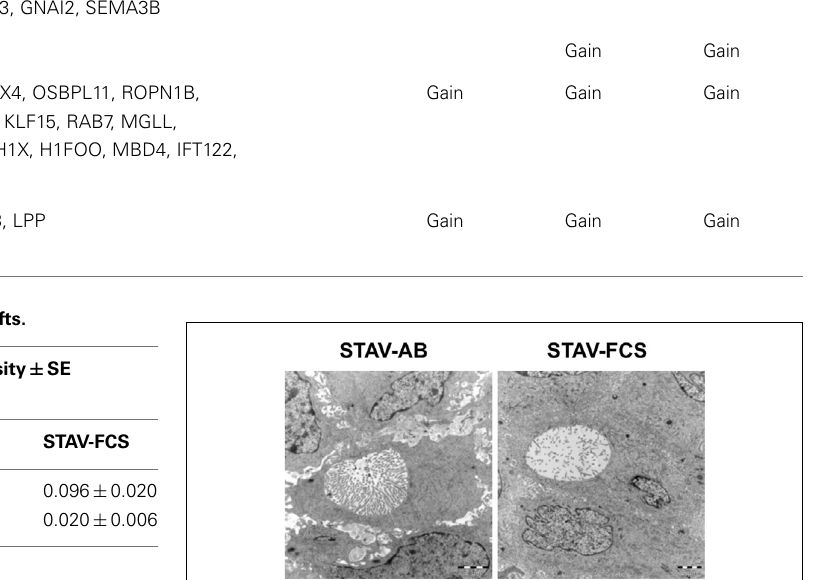
Table 4 | Microvessel density in xenografts (vessels/mm 2 ). Distance from tumor